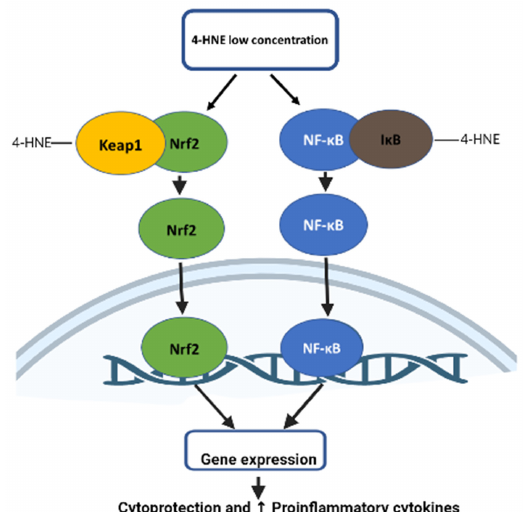
Figure 2. Signaling of 4-HNE in Nrf2 and NF- κ B pathway. Lower concentrations of 4-HNE lead to the induction of transcription factor Nrf2 (nuclear factor erythroid-2-related factor 2) and NF- κ B (nuclear factor kappa B (NF- κ B). This increase in Nrf2 causes an increase in gene expression, which leads to cardioprotection by enhancing synthesis of antioxidants. Increase in NF- κ B leads to increased ( ↑ ) pro-inflammatory cytokine expression.